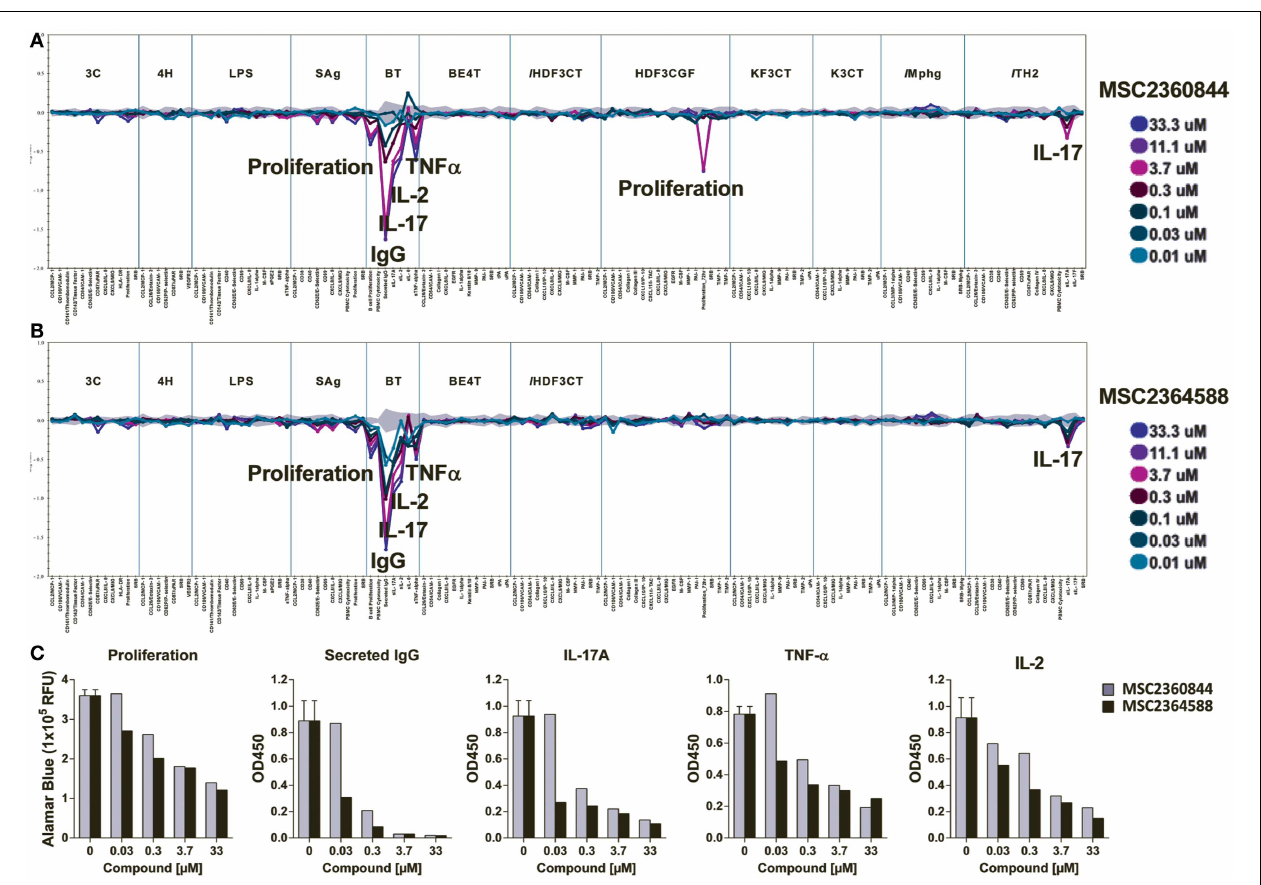
were measured by ELISA and presented as log expression ratios [log10 (parameter value with test compound/parameter value of 0.1%DMSO)].The gray area represents the 95% prediction interval of the 0.1% DMSO data. Significantly altered readouts are annotated. (C) Effects of MSC2360844 and MSC2364588 on annotated readouts from B–T assays. Level of proliferation was represented by relative fluorescent units (RFU) of Alamar Blue. Cytokines were measured by ELISA and presented as artificial unit of optical density at 450nm